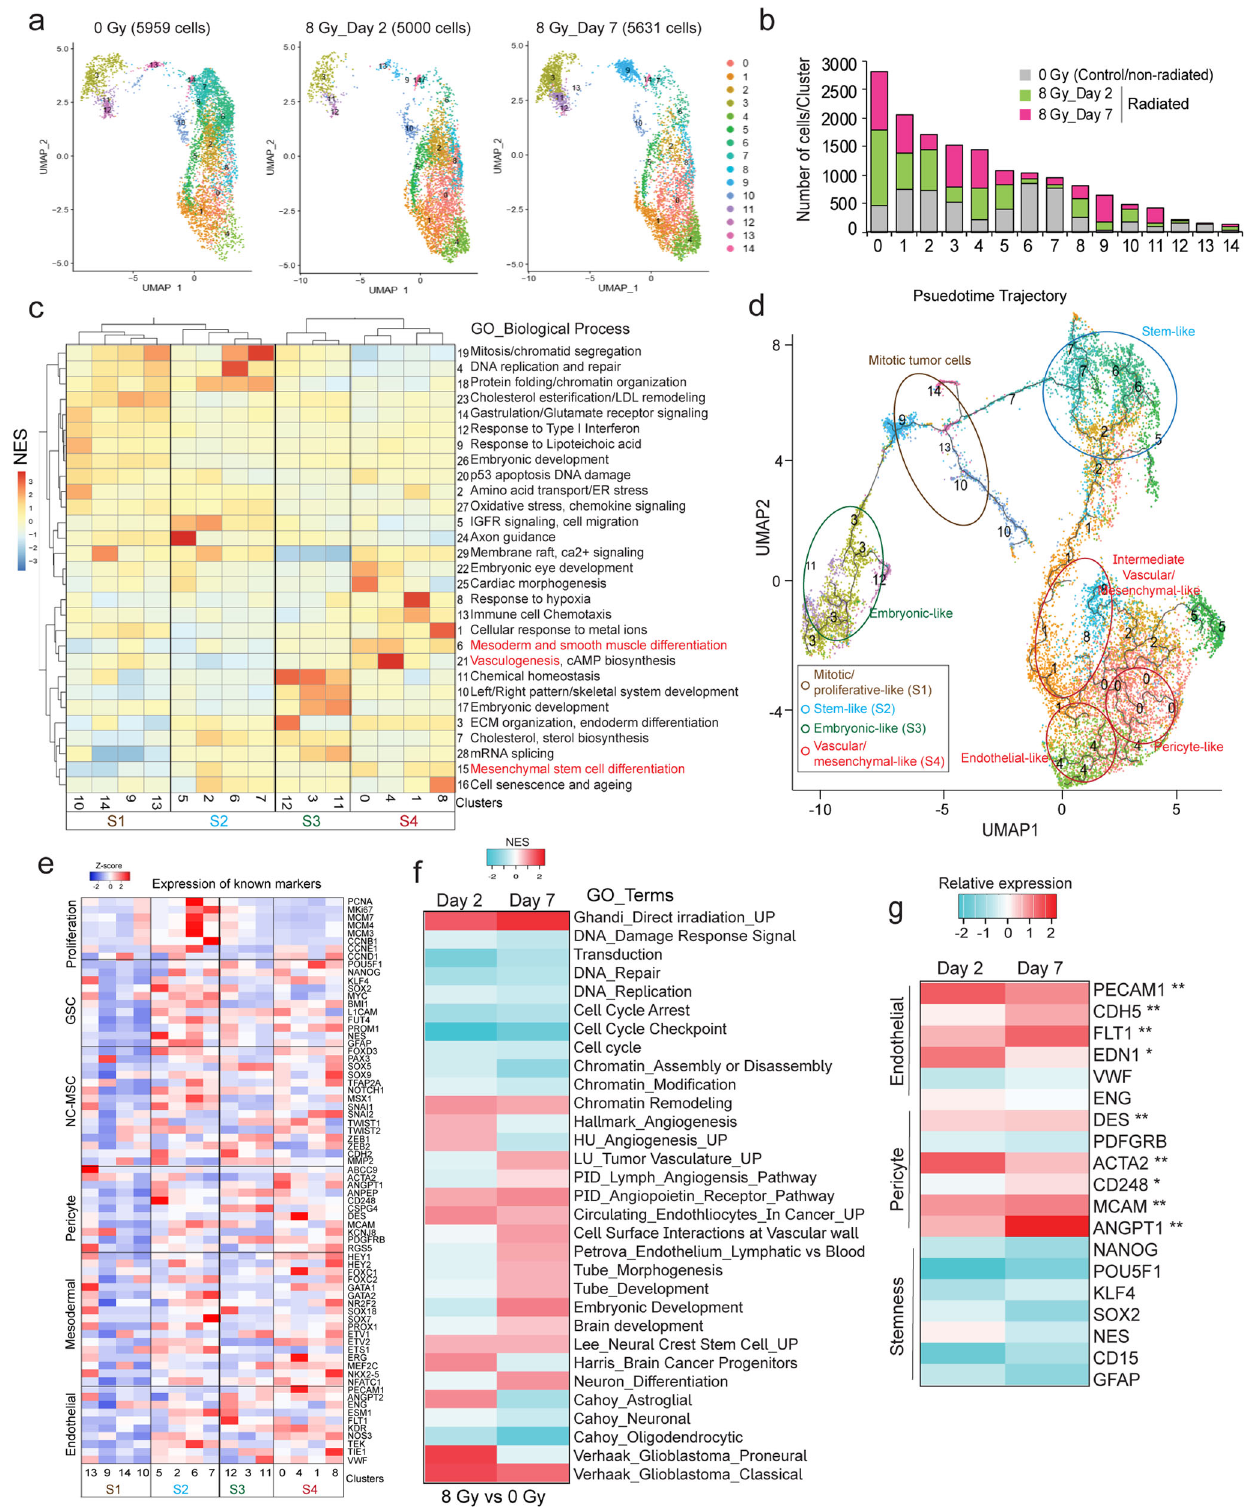
Fig. 1 | Single-cell sequencing reveals the diverse functional states of glioma cells post-radiation. a UMAP plot of cell clusters from control (0Gy) and 2- and 7-daysradiated(8Gy)fractions. b Histogramshowsthenumberofcellspercluster in each group. c Heatmap shows Louvain clustering ofco-expressed gene network modules and EnrichR GO_terms associated with each cluster. Each subgroup is highlighted by a black box. d Pseudotime trajectory analysis, subgroups are high- lighted in colored circles and their functional cell states indicated in the inset.